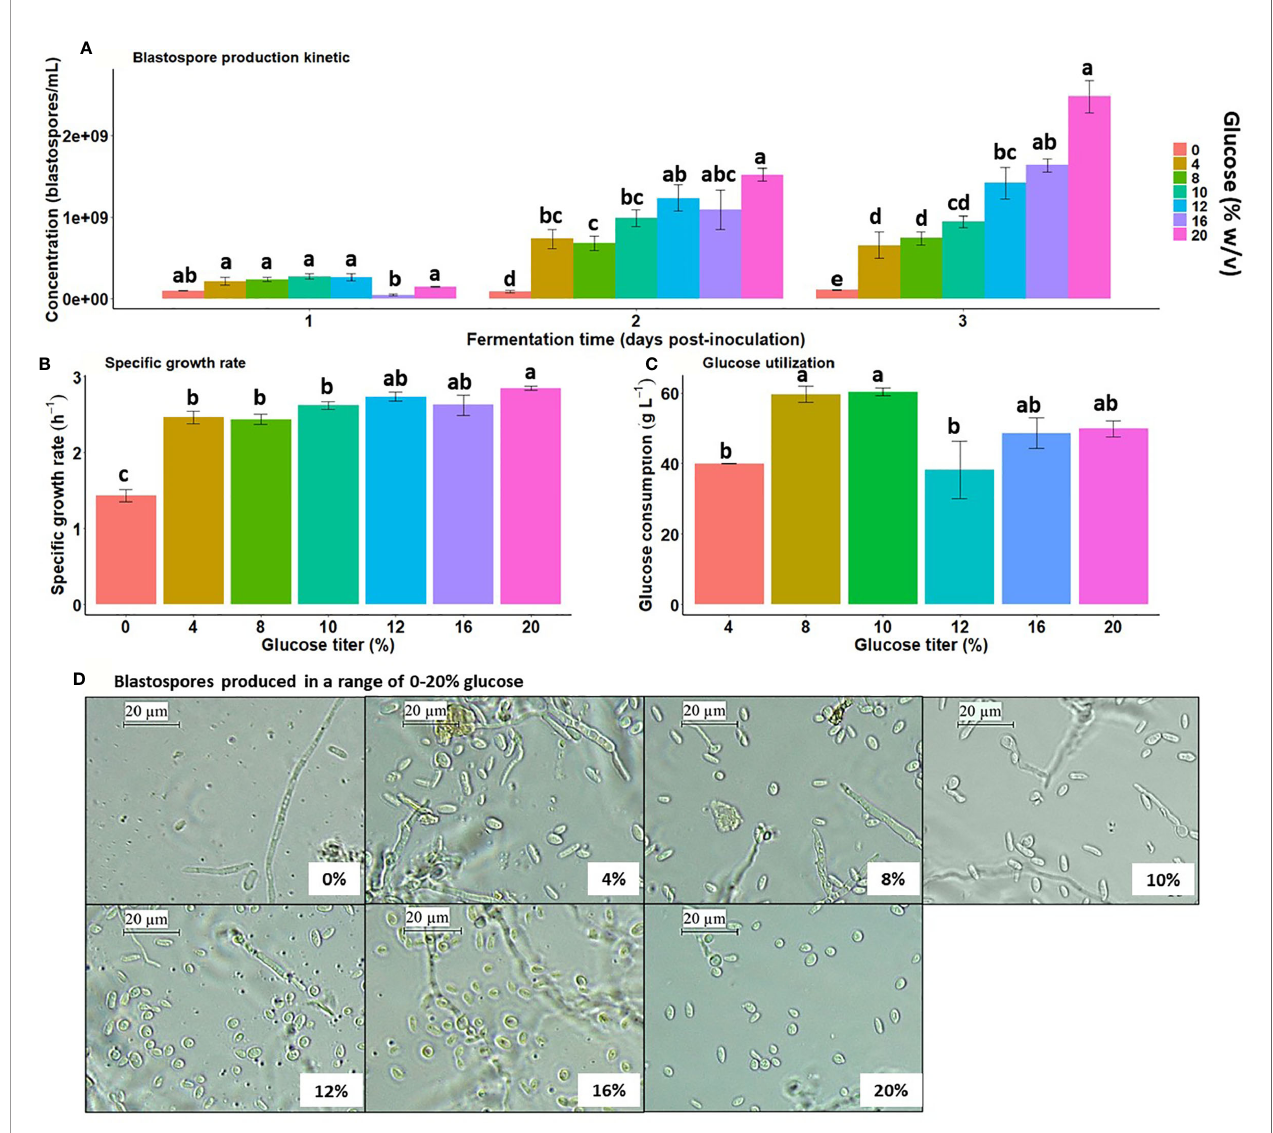
FIGURE 1 | Blastospore yield and growth kinetics are signi fi cantly boosted by greater glucose gradient (0 to 20% w/v) under high aeration during submerged liquid culture conditions. (A) B. bassiana (strain GHA) blastospore concentration in liquid culture with a greater glucose titer gradient at 28 °C, 350 rpm, and 50 mL of fi lling volume. (B) Maximum speci fi c growth rate during log-phase growth across glucose titer gradient. (C) Glucose consumption at day 3 post-inoculation across glucose titer gradient. Bar heights represent means, and error bars are standard error of means ( ± S.E.). (D) Blastospore morphotypes induced by different glucose titers (photographs taken at day 3 of fermentation). Vertical bars within each fermentation time are signi fi cantly different when followed by distinct letters (Tukey HSD, p <